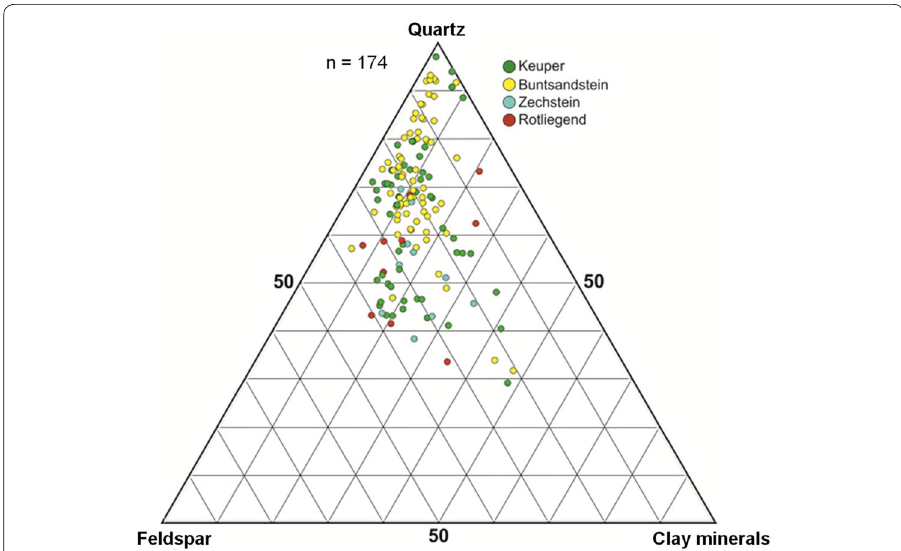
Fig. 3 Ternary diagram of RVA results (vol.%) of sandstones using quartz, feldspar, and clay minerals